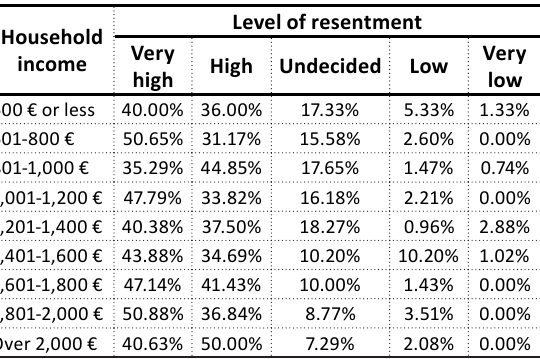
Table 3. Level of resentment towards dual quality structured by